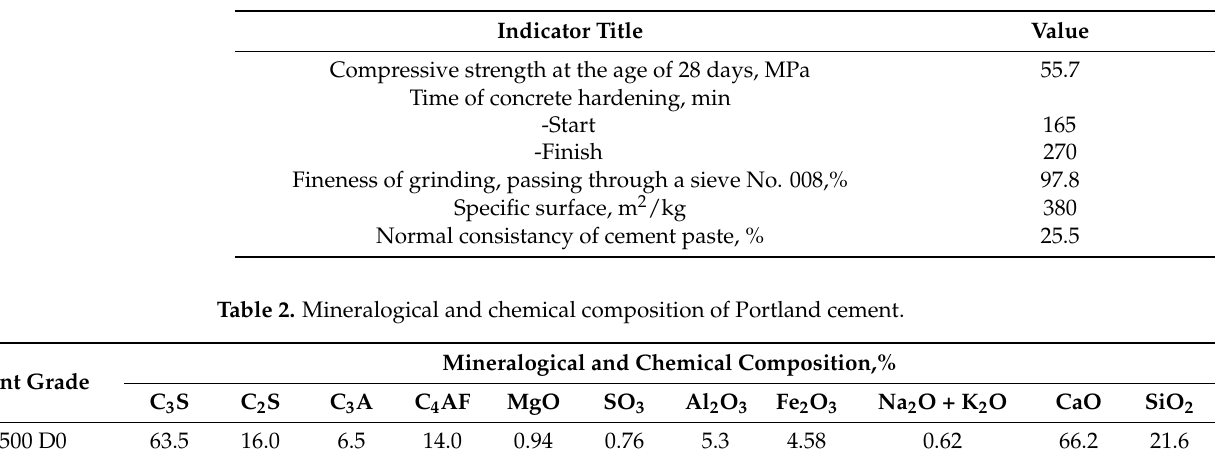
Table 1. Physical and mechanical characteristics of Portland cement PC 500 D0.